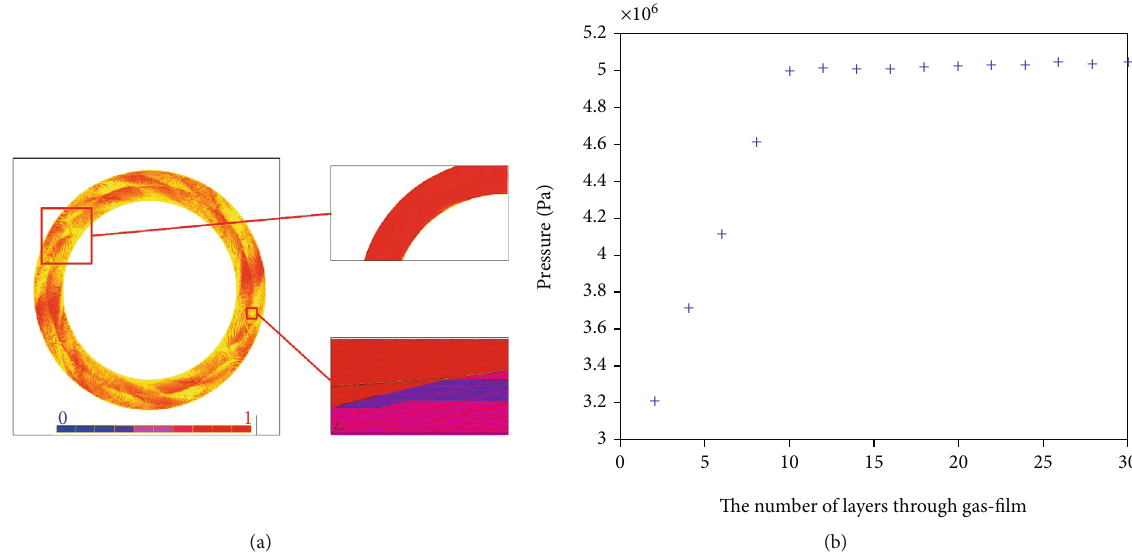
Figure 2: The mesh model and mesh sensitivity of spiral-grooved thrust bearing.